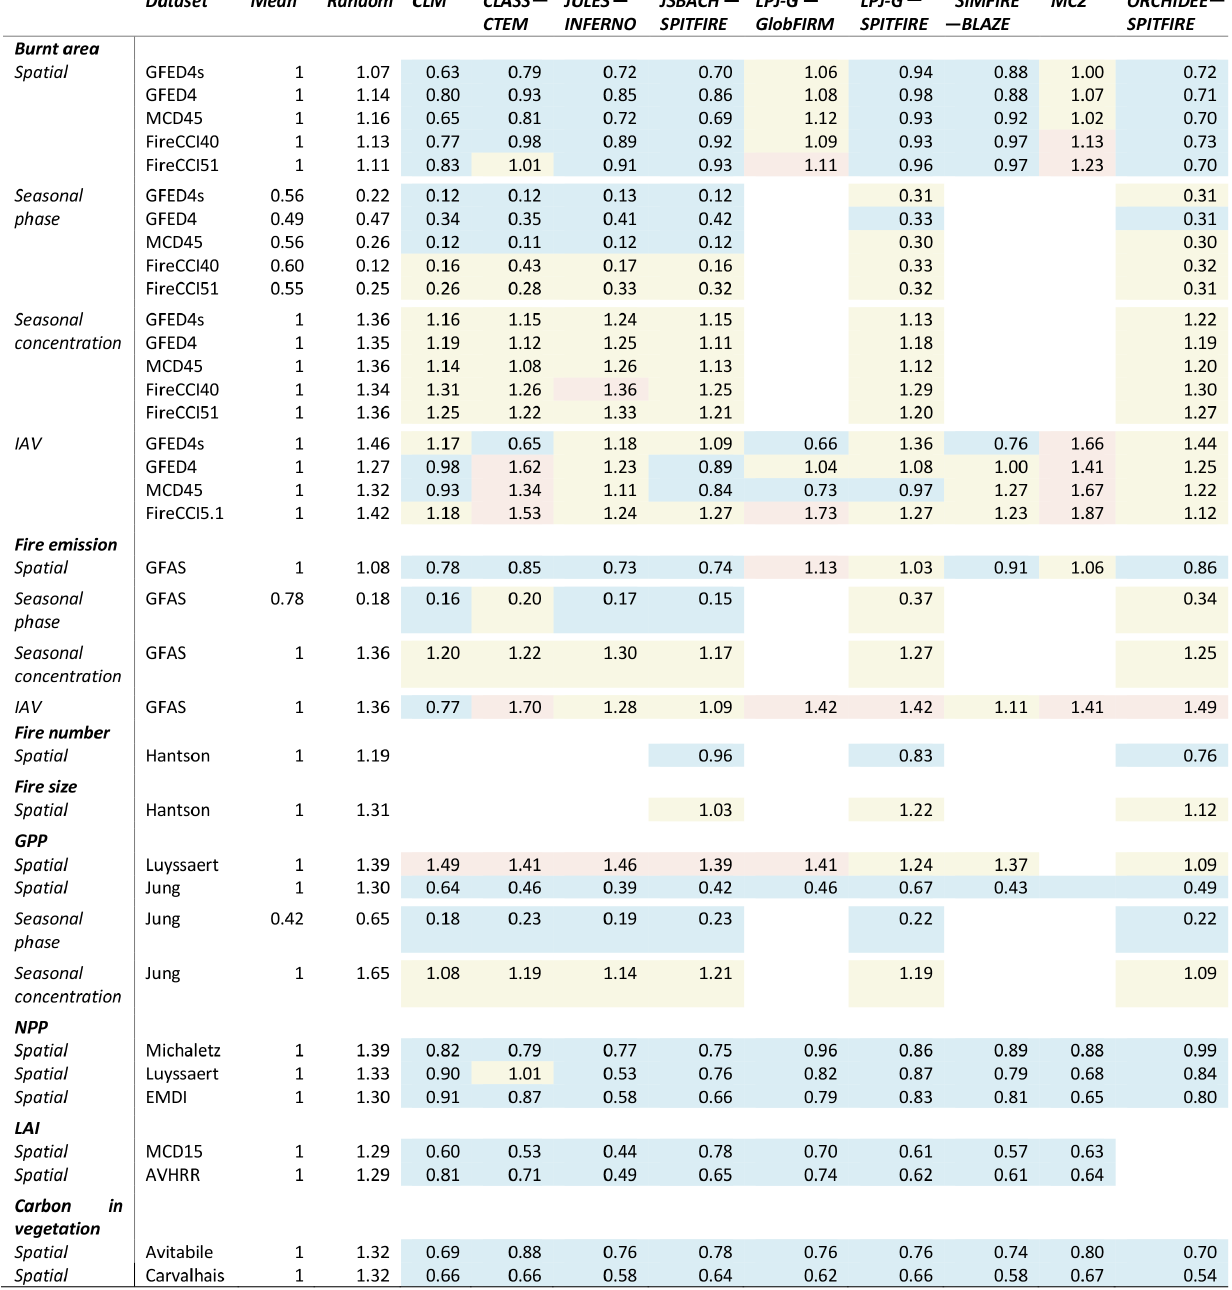
Table 3. Benchmarking scores after removing the influence of differences in the mean and variance for each individual global fire model for key fire and vegetation variables. A lower score is “better”, with a perfect score equal to 0. The full table with all benchmarking scores is presented in Table S1 in the Supplement. LPJ–G: LPJ–GUESS. Cell are coloured blue if the benchmarking score is lower than both null models, yellow if lower than 1 null model and red when higher than both null